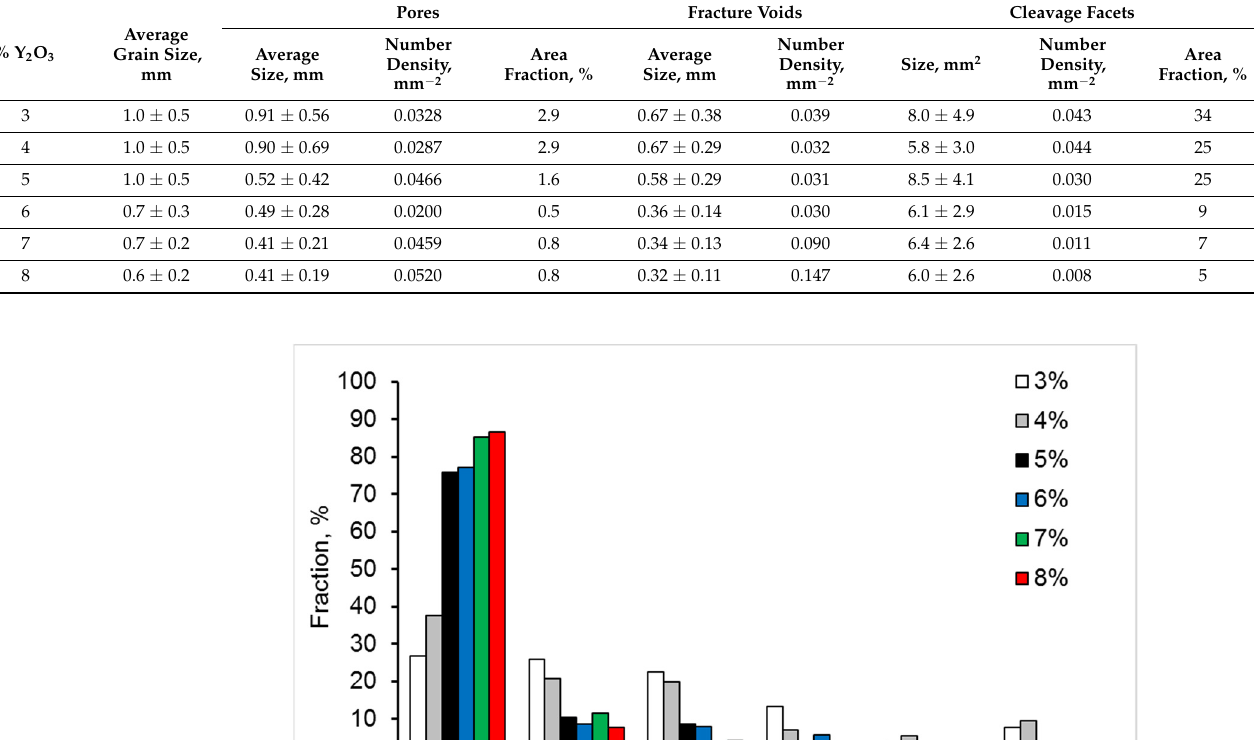
Table 1. Average parameters of microstructure and fracture surface.